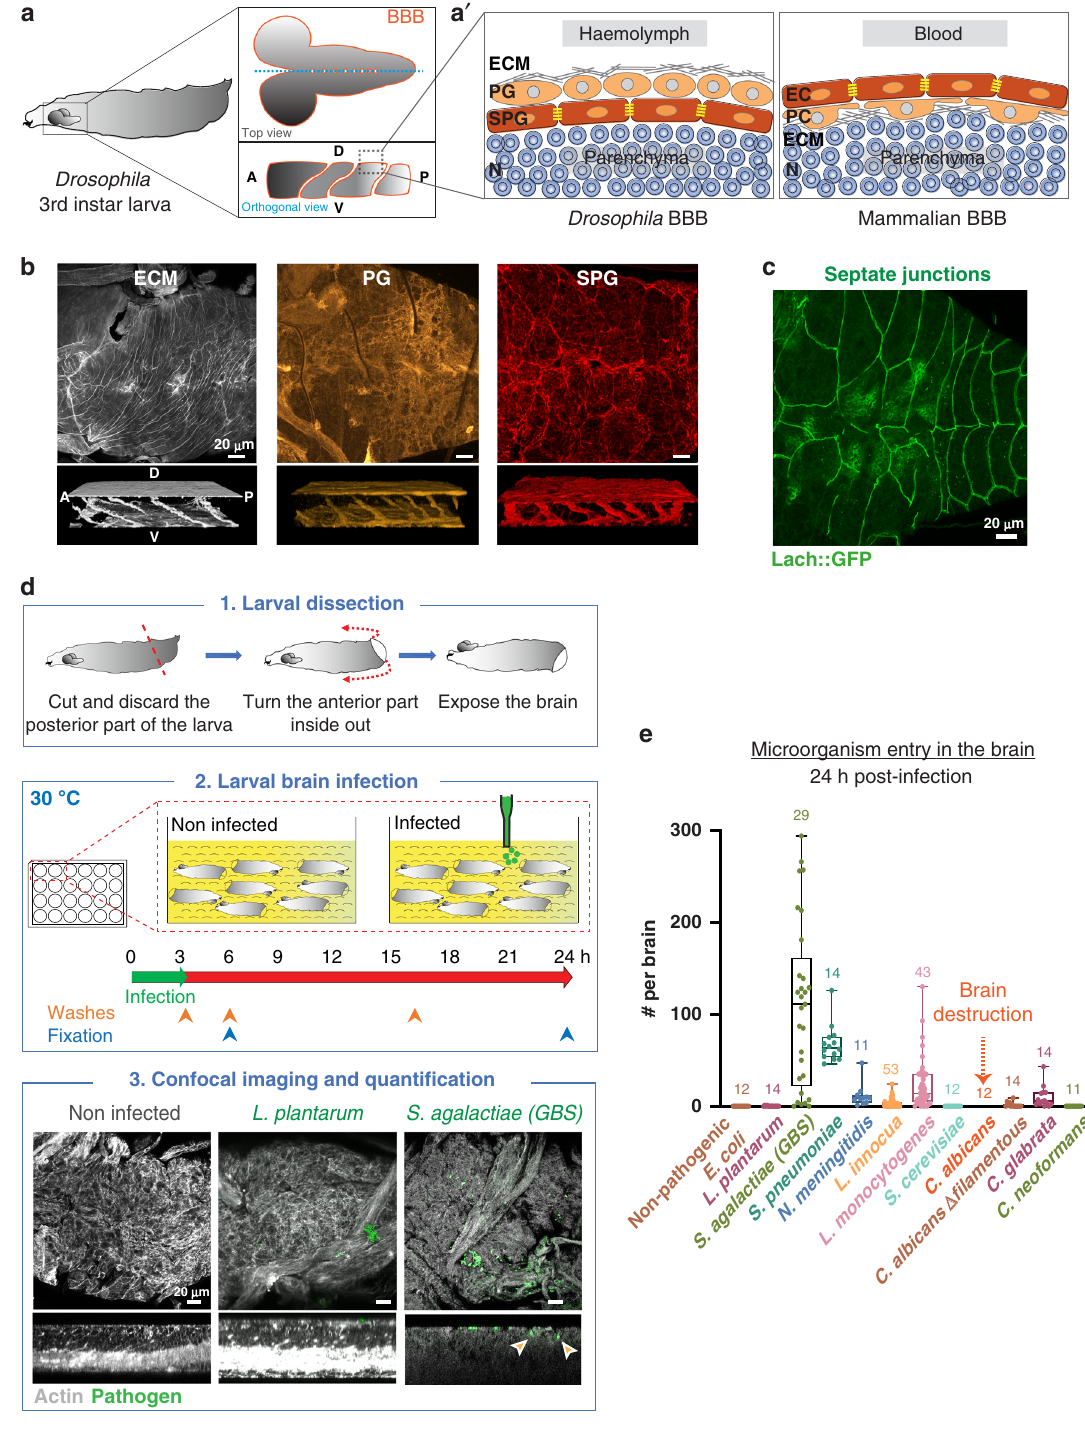
GFP 27 and trol::GFP 28 ) to visualise conserved components of the ECM (respectively collagen IV and heparan sulfate